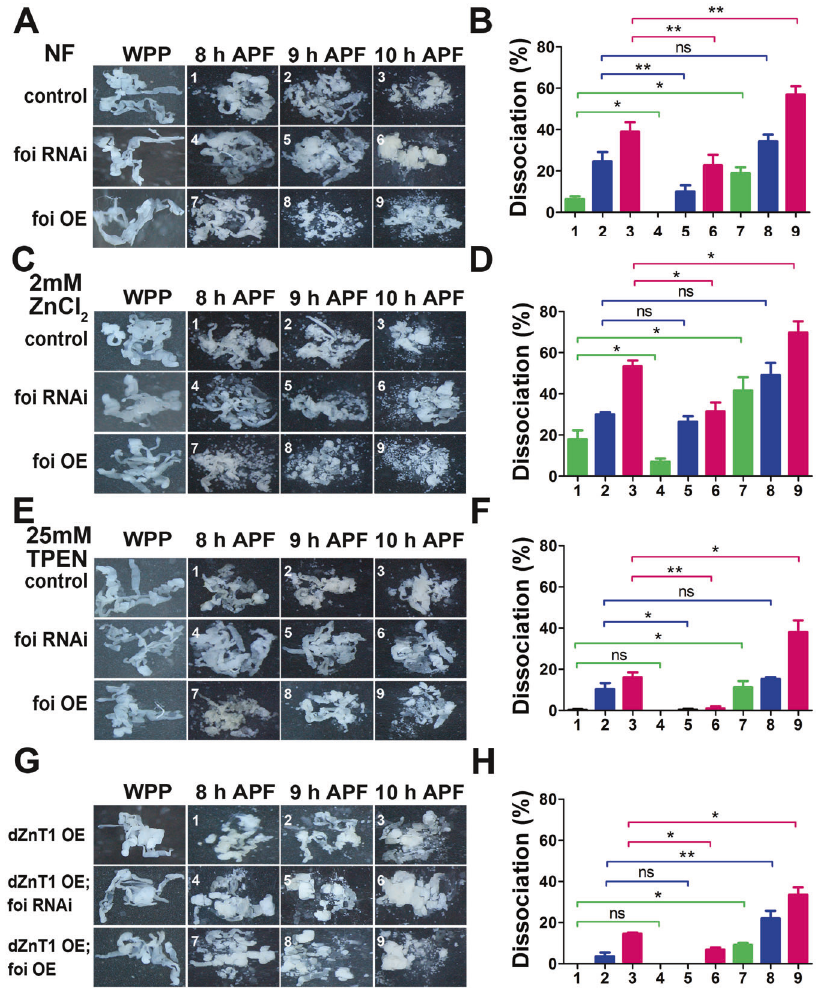
times. ns: not signi fi cant, * P < 0.05, ** P < 0.01, *** P < 0.001, two-tailed Student ’ s t (Fig. 2E), with 22% and 19% decrease in foi RNAi and foi OE animals, respectively (Fig. 2F). In addition, compared with normal diet, zinc supplementation induced the fat body cell dissociation (from 39% to 54%), while zinc de fi ciency reduced this progression (from 39% to 18%) in wild-type animals at 10 h APF (Fig. 2A – F). This indicates that the regulation of foi on the progression of the fat body cell dissociation could be modulated by dietary intervention of zinc and further strengthens the notion that zinc is involved in the fat body cell dissociation. As an alternative to examine the role of zinc homeostasis in the progression of the fat body cell dissociation, a well-established plasma membrane zinc transporter dZnT1/CG17723 (also named ZnT63C) [41] was selected to test the effect on fat body cell dissociation. dZnT1 functions in the opposite direction with foi [20, 28]. We observed that fat body-speci fi c dZnT1 OE vastly postponed the fat body cell dissociation (from 39% to 15%) and its dissociation rate was even lower than that of foi RNAi (~23%) at 10 h APF. Besides, the retarded fat body cell dissociation of foi RNAi could be aggravated by dZnT1 OE (from 23% to 7% at 10 h APF); dZnT1 OE was able to rescue the premature cell dissociation caused by foi OE